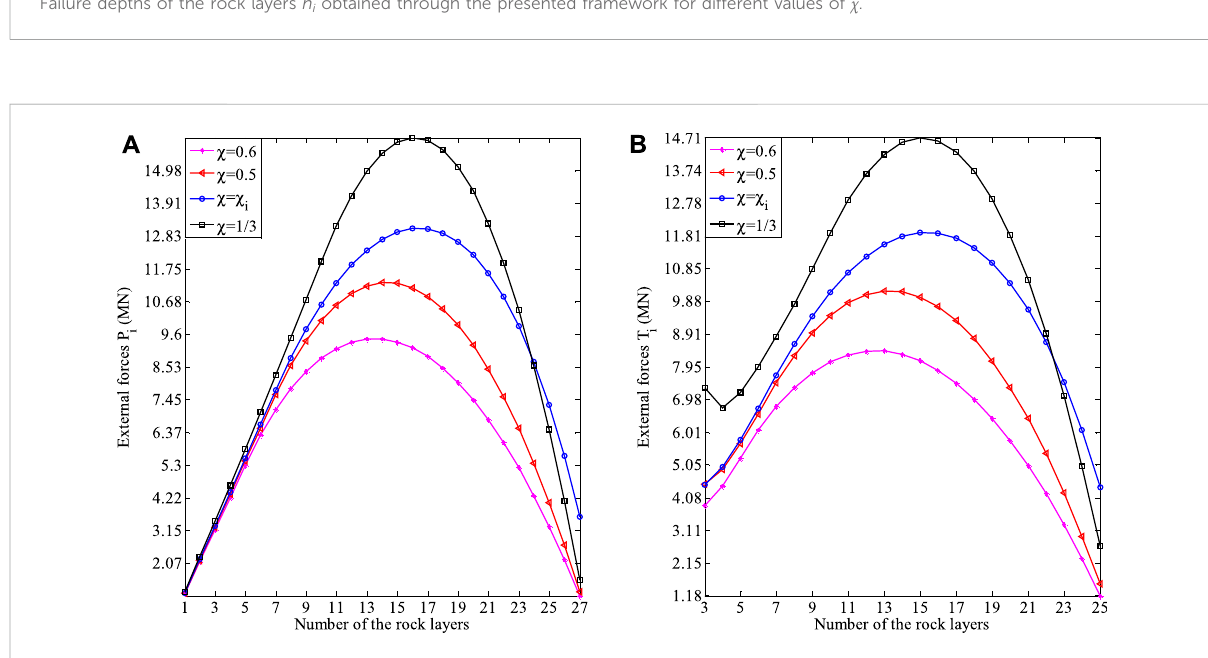
FIGURE 20 Results obtained through the presented framework for different values of χ : (A) the external forces prompting the rock layers to undergo shear sliding failure P i ; (B) the external forces prompting the rock layers to undergo fl exural toppling failure T i .